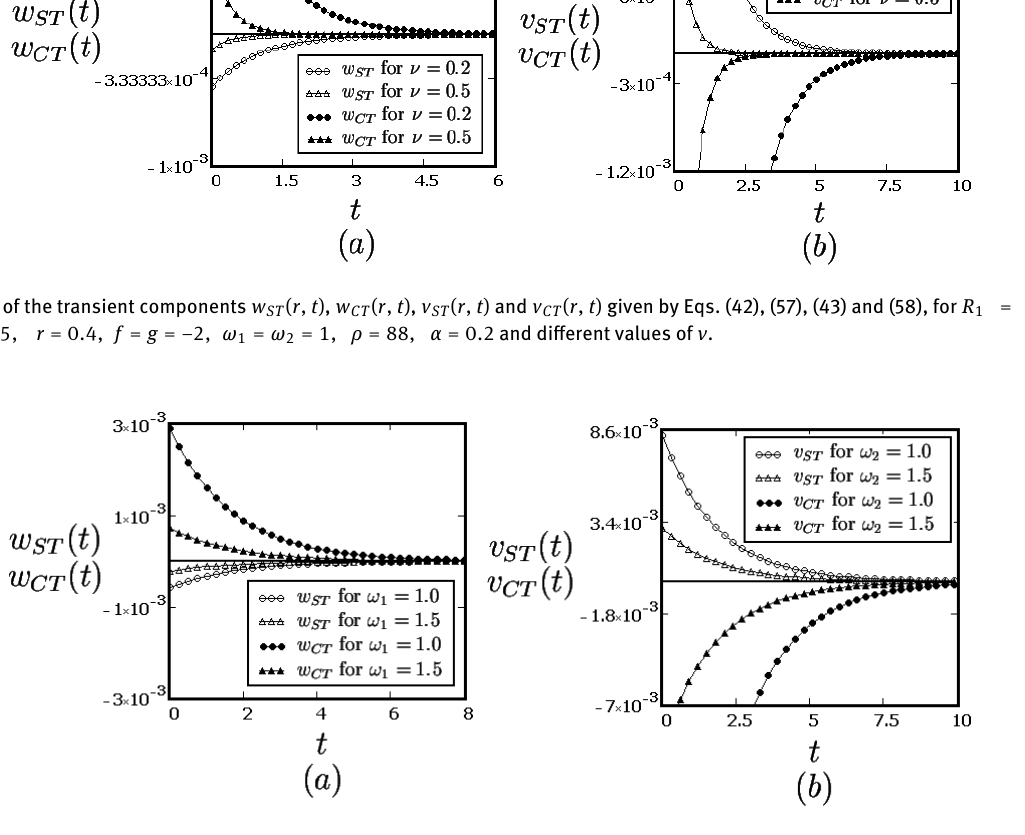
Fig. 3. Decay of the transient components w ST ( r , t ) , w CT ( r , t ) , v ST ( r , t ) and v CT ( r , t ) given by Eqs. (42), (57), (43) and (58), for R 1 = 0.3, R 2 = 0.5, r = 0.4, f = g = −2, ν = 0.1188, µ = 10.384, α = 0.2 and different values of ω 1 and ω 2